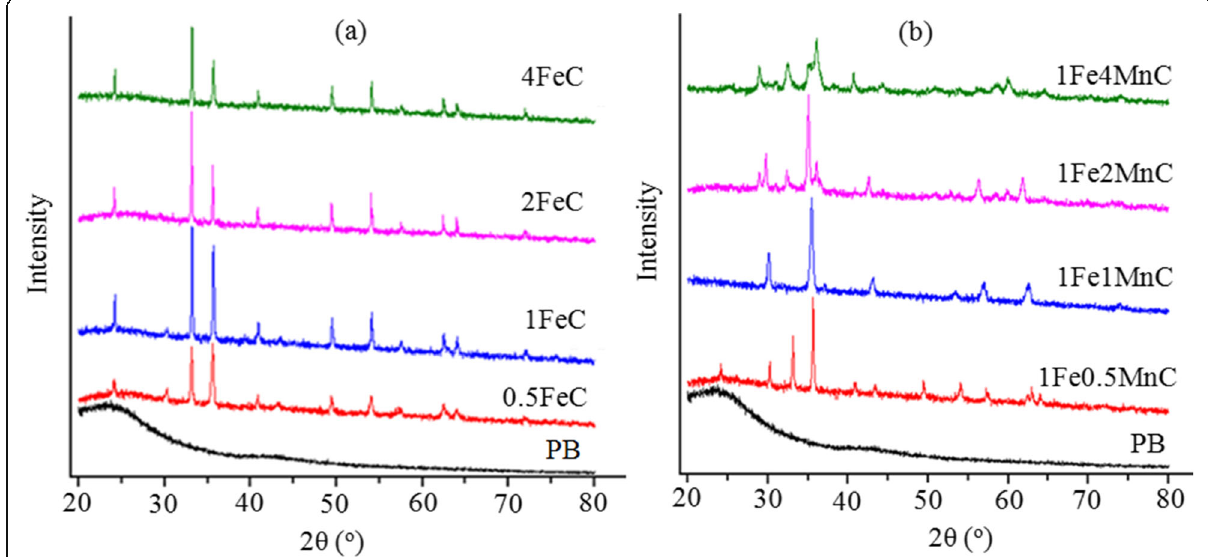
Fig. 1 The XRD analysis of a x FeC and b x Fe y